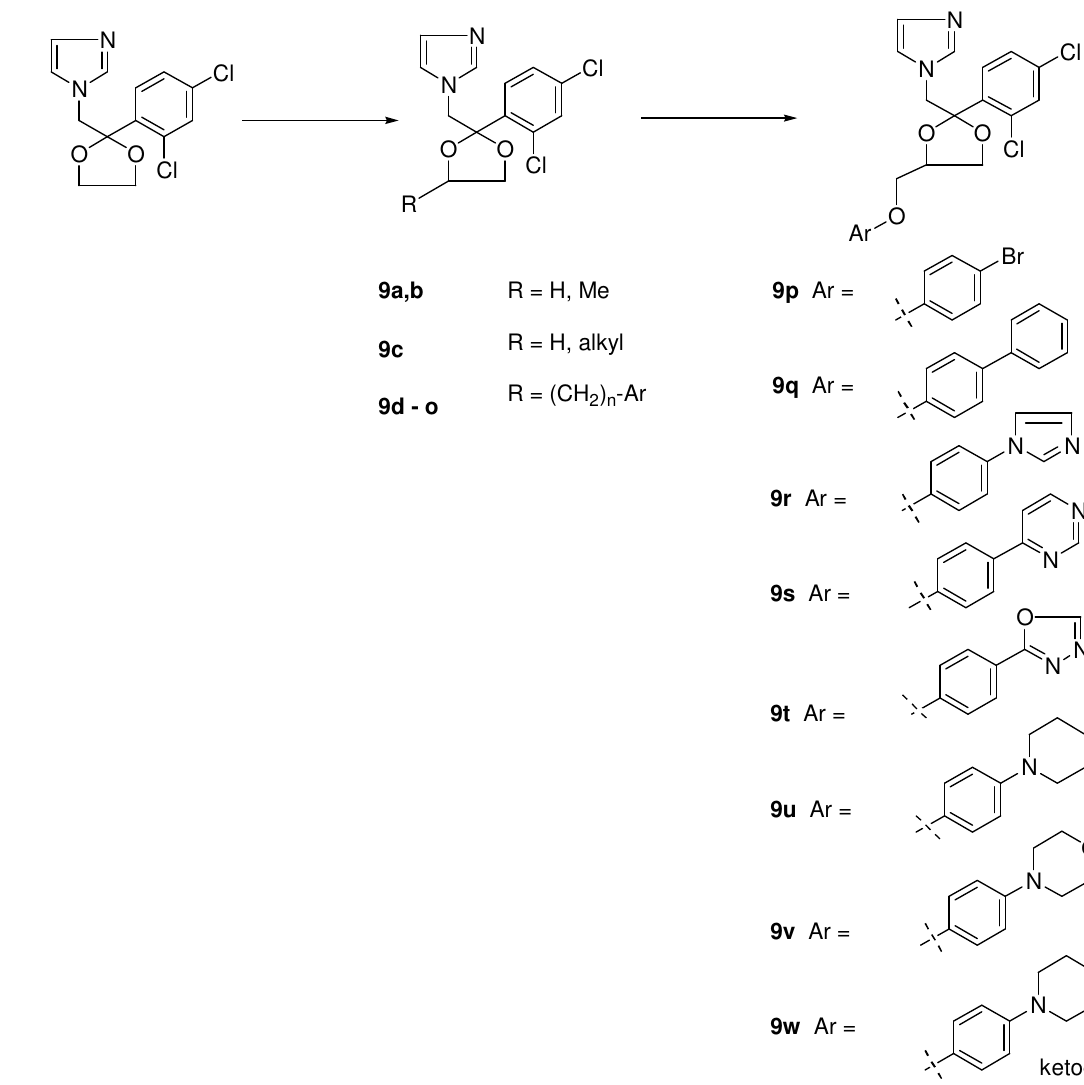
Figure 3. The evolution from simple imidazolyl dioxolanes to